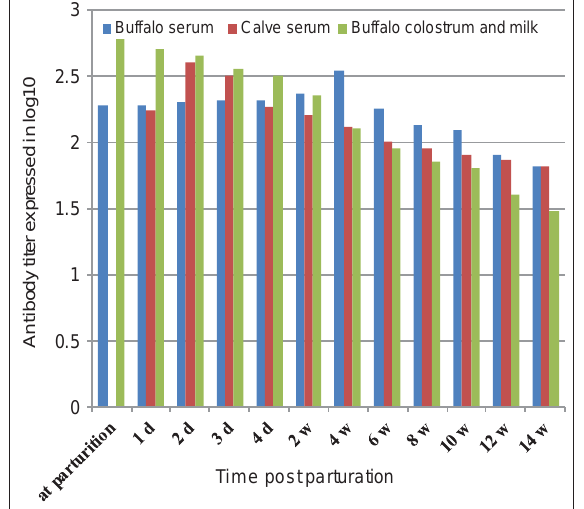
Figure 5: Comparison between the mean antibody titer of serum and colostrum of naturally infected buffalo, their calves by enzyme linked immunosrobent assay.